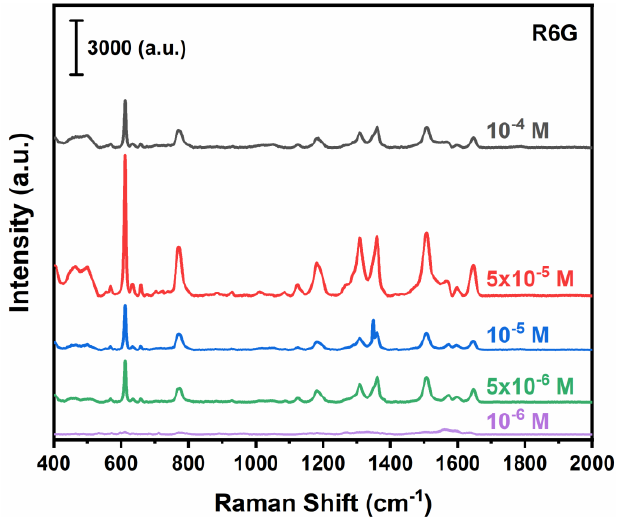
Figure 7. SERS spectra of PDMS-BWS-Ag35 with various concentrations of R6G molecules (from 10 −4 to 10 −6 M).